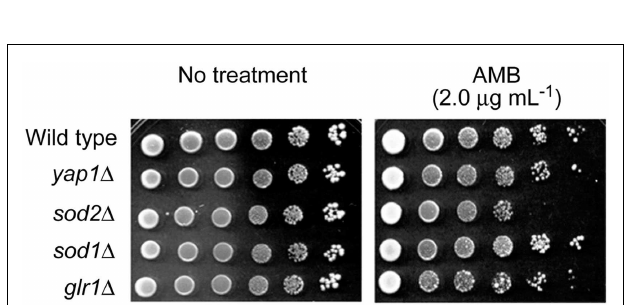
FIGURE 1 | Dilution bioassays showing phenotypic responses of yeast pathogens to amphotericin B (AMB) or diamide. 1 × 10 6 cells were serially diluted 10-fold in SG liquid medium, and were inoculated onto agar plates. Data are representative results shown from 1 µ gmL − 1 (AMB) and 0.8mM (diamide), respectively.